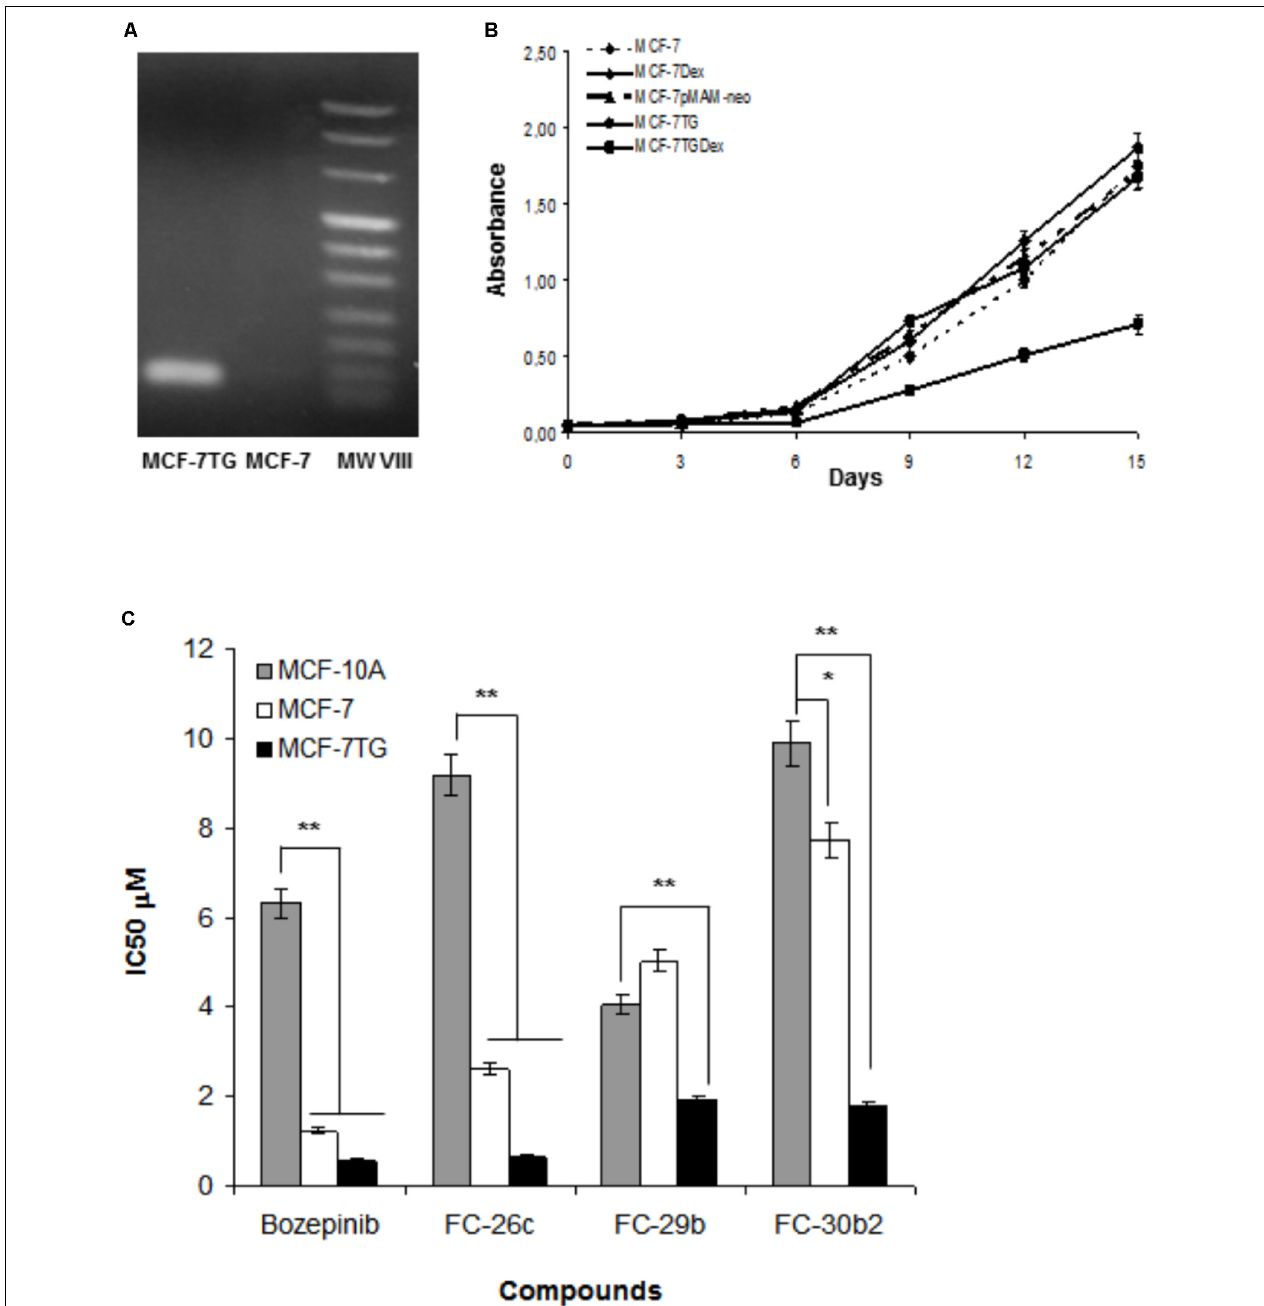
FIGURE 2 | (A) Detection of the gef gene expression in MCF-7TG cells by RT-PCR. (B) Determination of the effects of gef gene expression on MCF-7 cell proliferation. MCF-7 Dex, MCF-7pMAM-neo, MCF-7TG were used as control. (C) Comparison between antiproliferative activities of bozepinib, FC-26c, FC-29b, and FC-30b2 against the MCF-7 and MCF-7TG cancer cell lines, and the MCF-10A epithelial cell line. Data are expressed as the mean ± standard error of the mean of three independent experiments. ∗ P < 0.05, ∗∗ P < 0.01 ( t -test).